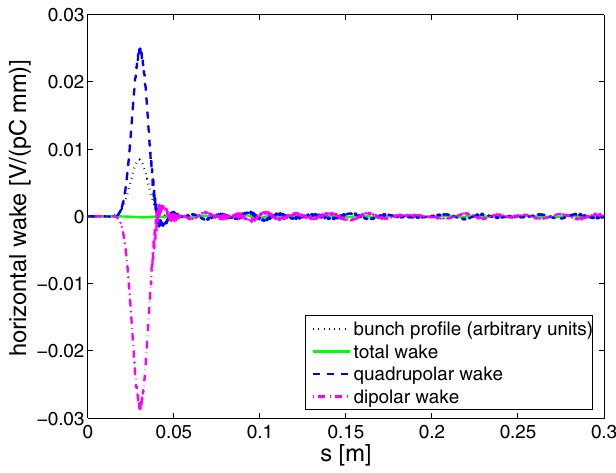
FIG. 8. (Color) Decomposition of the total horizontal wake (green) in its dipolar part (magenta) and quadrupolar part (blue). The black dashed curve is the electron beam profile.